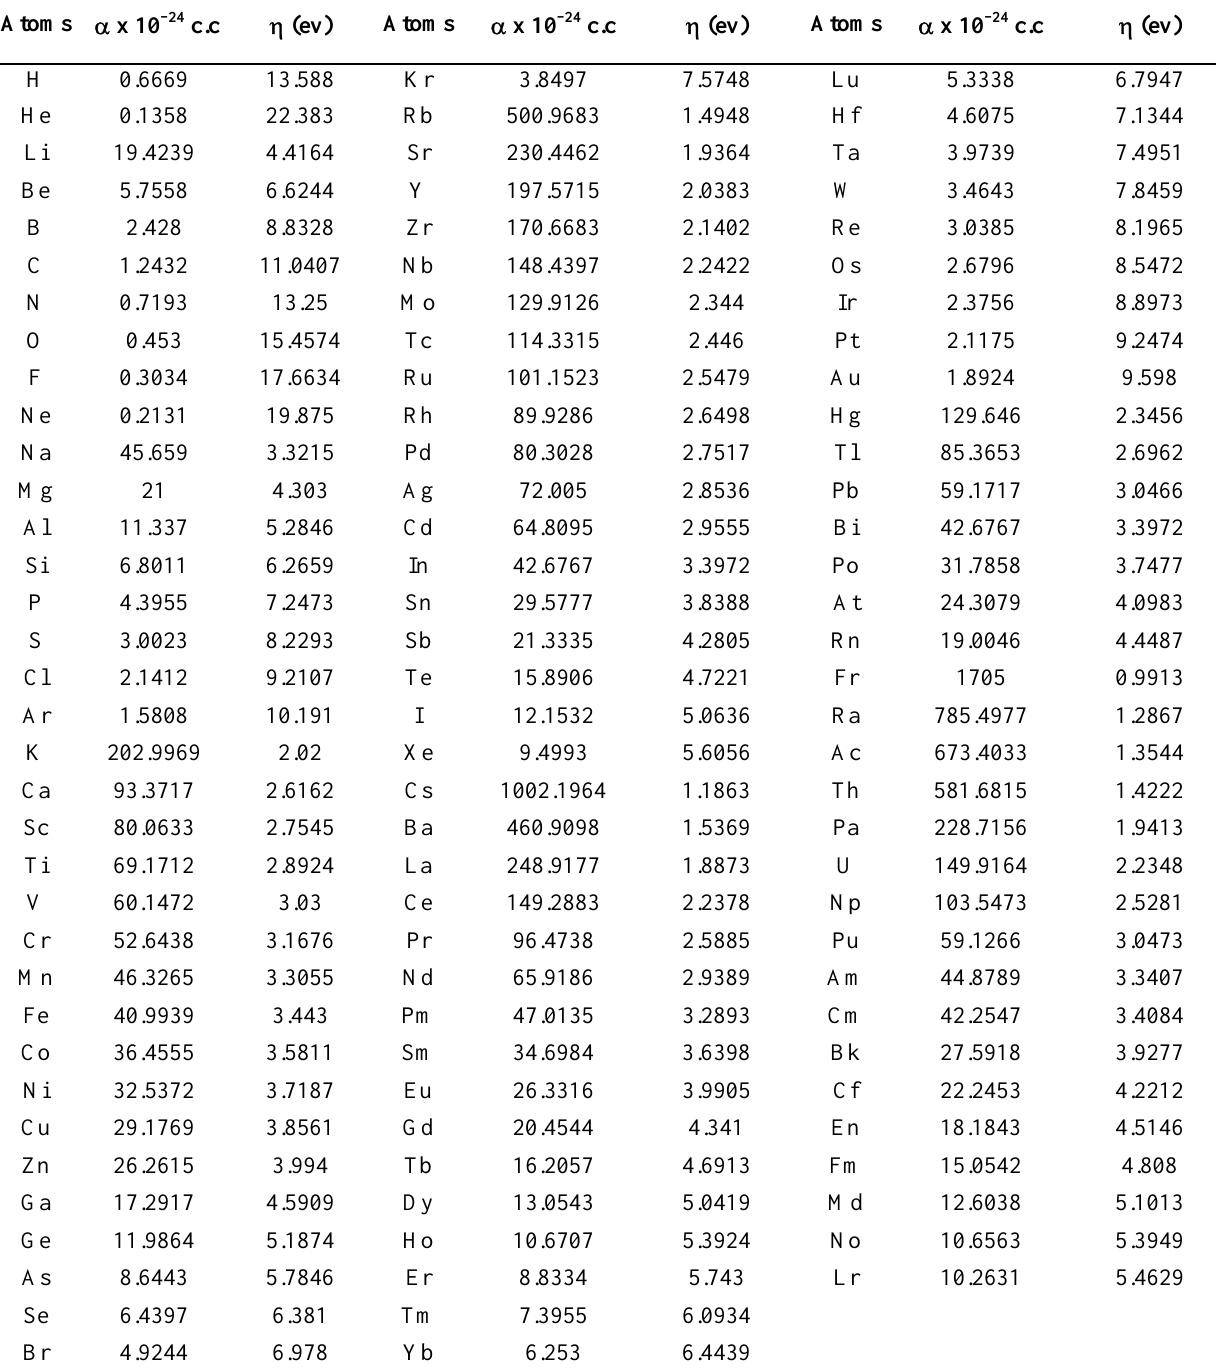
Table 3. Computed atomic polarizability ( α ) and global hardness ( η ) of atoms. Atoms α x 10 –24